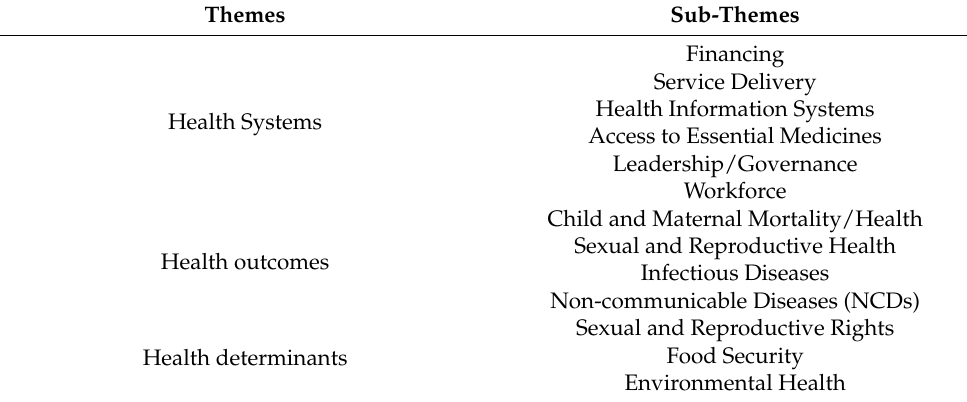
Table 1. Themes and sub-themes from the